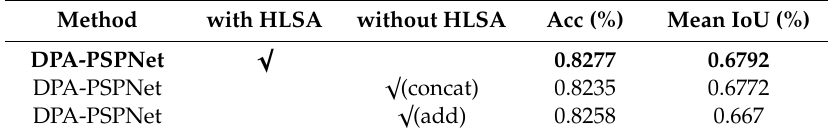
Table 1. Performance comparison between di ff erent DPA-PSP-Net structures.